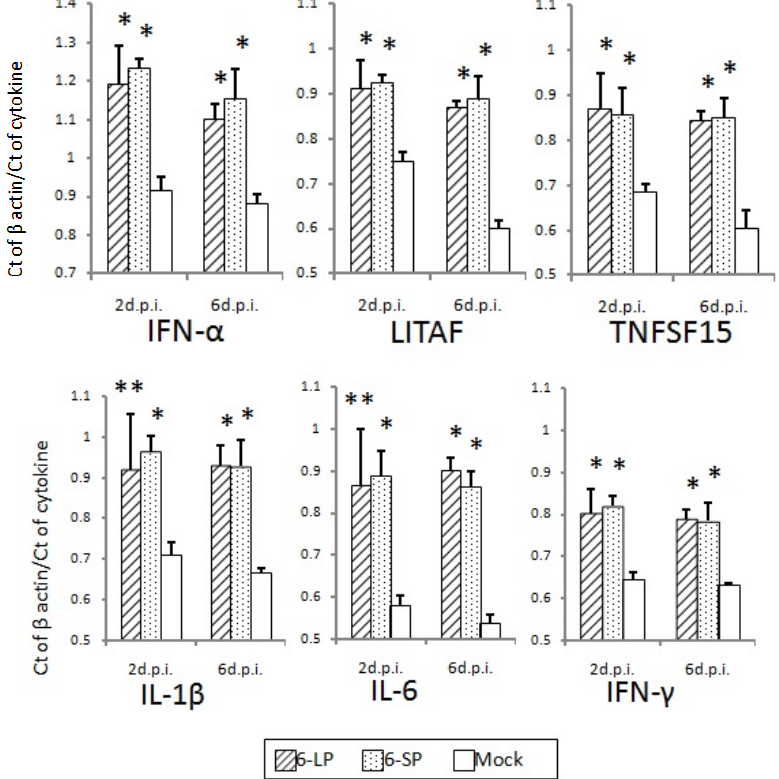
Figure 8. Cytokine and transcription factor mRNA levels in the spleens of 2-day-old chicks inoculated with WNV 6-LP or 6-SP. Chicks were infected with 10 2 PFU of virus administered subcutaneously in the femoral region, and tissues were collected at 2 and 6 days post infection (d.p.i.). Total RNA was then extracted and cDNA synthesized. SYBR Green-based quantitative real-time PCR was performed using the synthesized cDNA. Relative quantification of cytokine gene expression was done using the CT method. The CT data for each cytokine were normalized against the b-actin levels in the same sample. * and ** indicate statistically significant differences ( * p , 0.01; ** p , 0.05) in cytokine and transcription factor mRNA levels compared with mock-infected